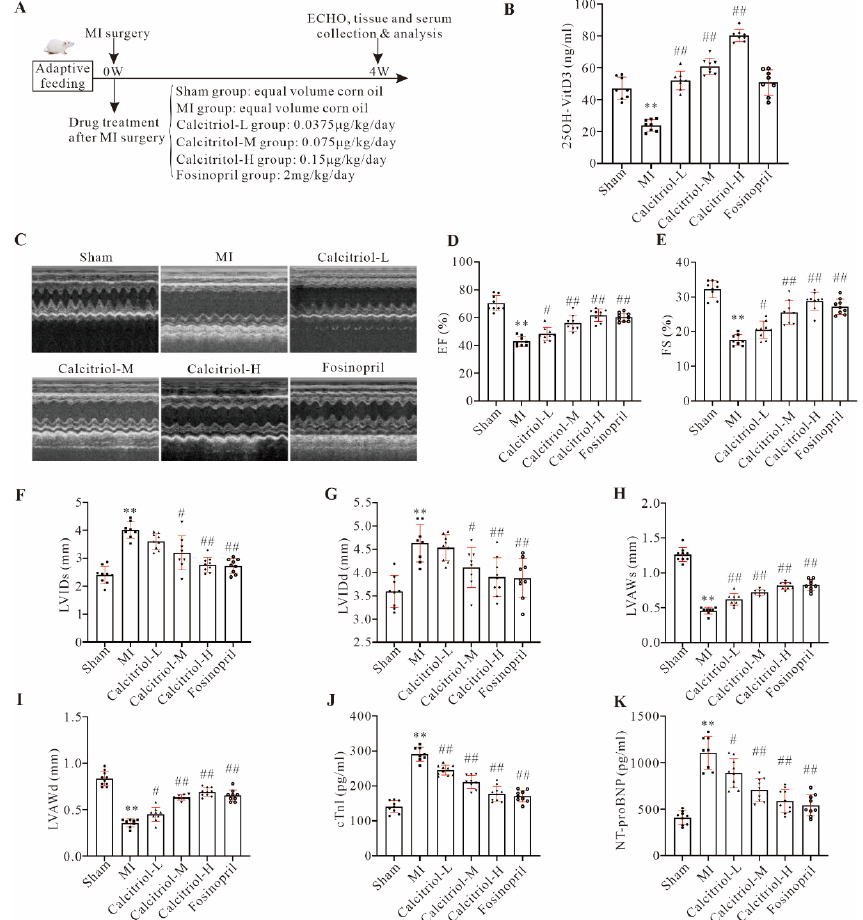
Figure 1. Calcitriol improved cardiac function in post-MI mice. ( A ) Experimental protocol of the in vivo study with the indicated treatments. All the samples/data were collected at the end of the study protocol (4 weeks post-MI/treatments). ( B ) Serum 25-OH vitamin D3 in mice with the indicated treatments. ( C – I ) Cardiac function analysis by echocardiogram. Representative images of echocardiography with M-mode ( C ) and quantitative analysis of EF ( D ), FS ( E ), LVIDs ( F ), LVIDd ( G ), LVAWs ( H ), and LVAWd ( I ) from eight or more mice, were presented here. ( J , K ) Serum cTnI and NT-proBNP levels in mice. (Data represent means ± S.D. n ≥ 8, * p < 0.05, ** p < 0.01 versus sham group, # p < 0.05, ## p < 0.01 versus MI group; one-way ANOVA with a post hoc test of Tukey’s analysis).